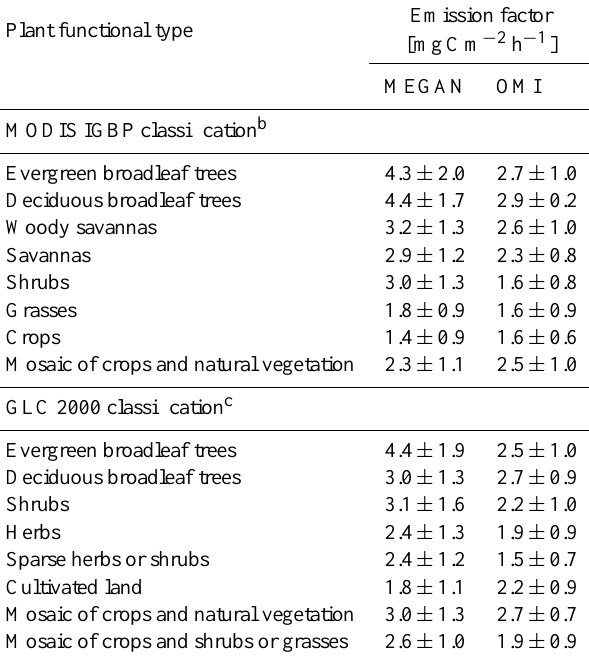
Table 2. Isoprene emission factors for African plant functional types a